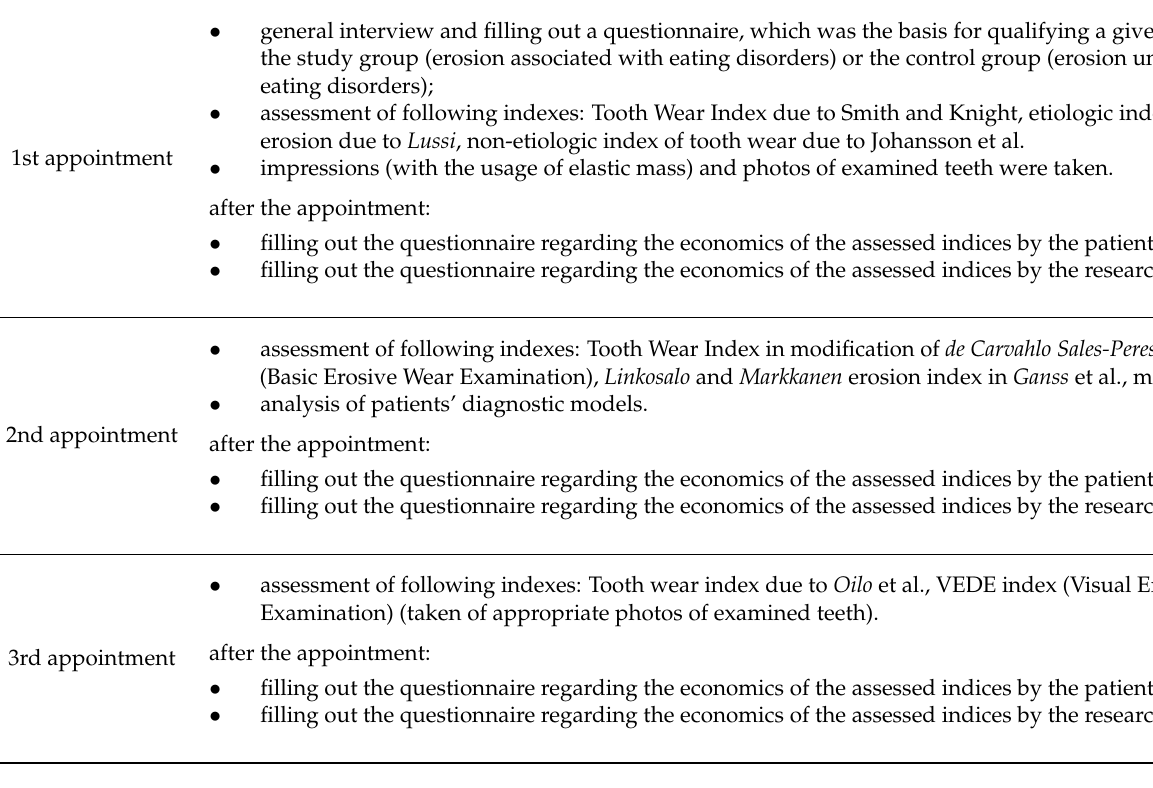
Table 1. Scheme of the research.